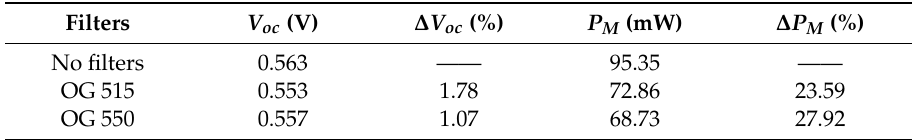
Table 4. Values of open circuit voltage, maximum power, and respective variations for different tests with and without HP filters for m-Si cell for an irradiance of 910 W/m 2 .